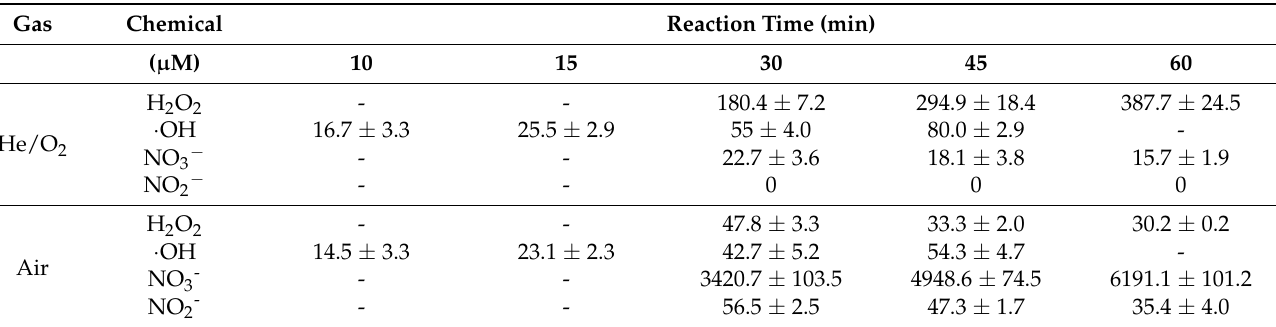
Table 1. Mean chemical concentrations ± SEM in gas-plasma-activated water during non-thermal atmospheric gas plasma